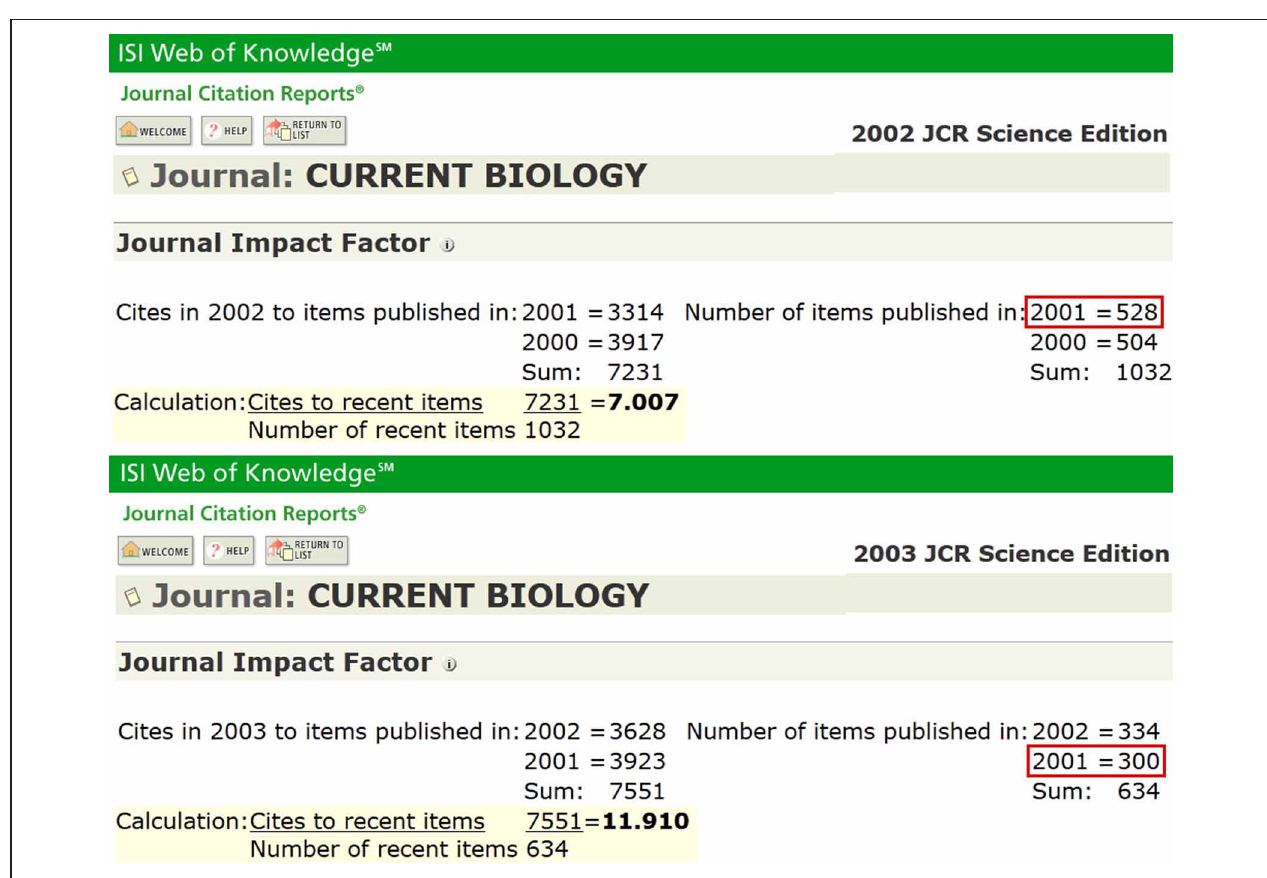
FIGURE A1 | Impact Factorof thejournal“CurrentBiology”in the years2002(above)and2003(below)showinga40%increaseinimpact. The increase in the IF of the journal “Current Biology” from approx. 7 to